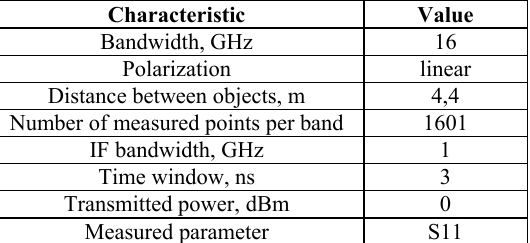
Table 1. Measuring bench